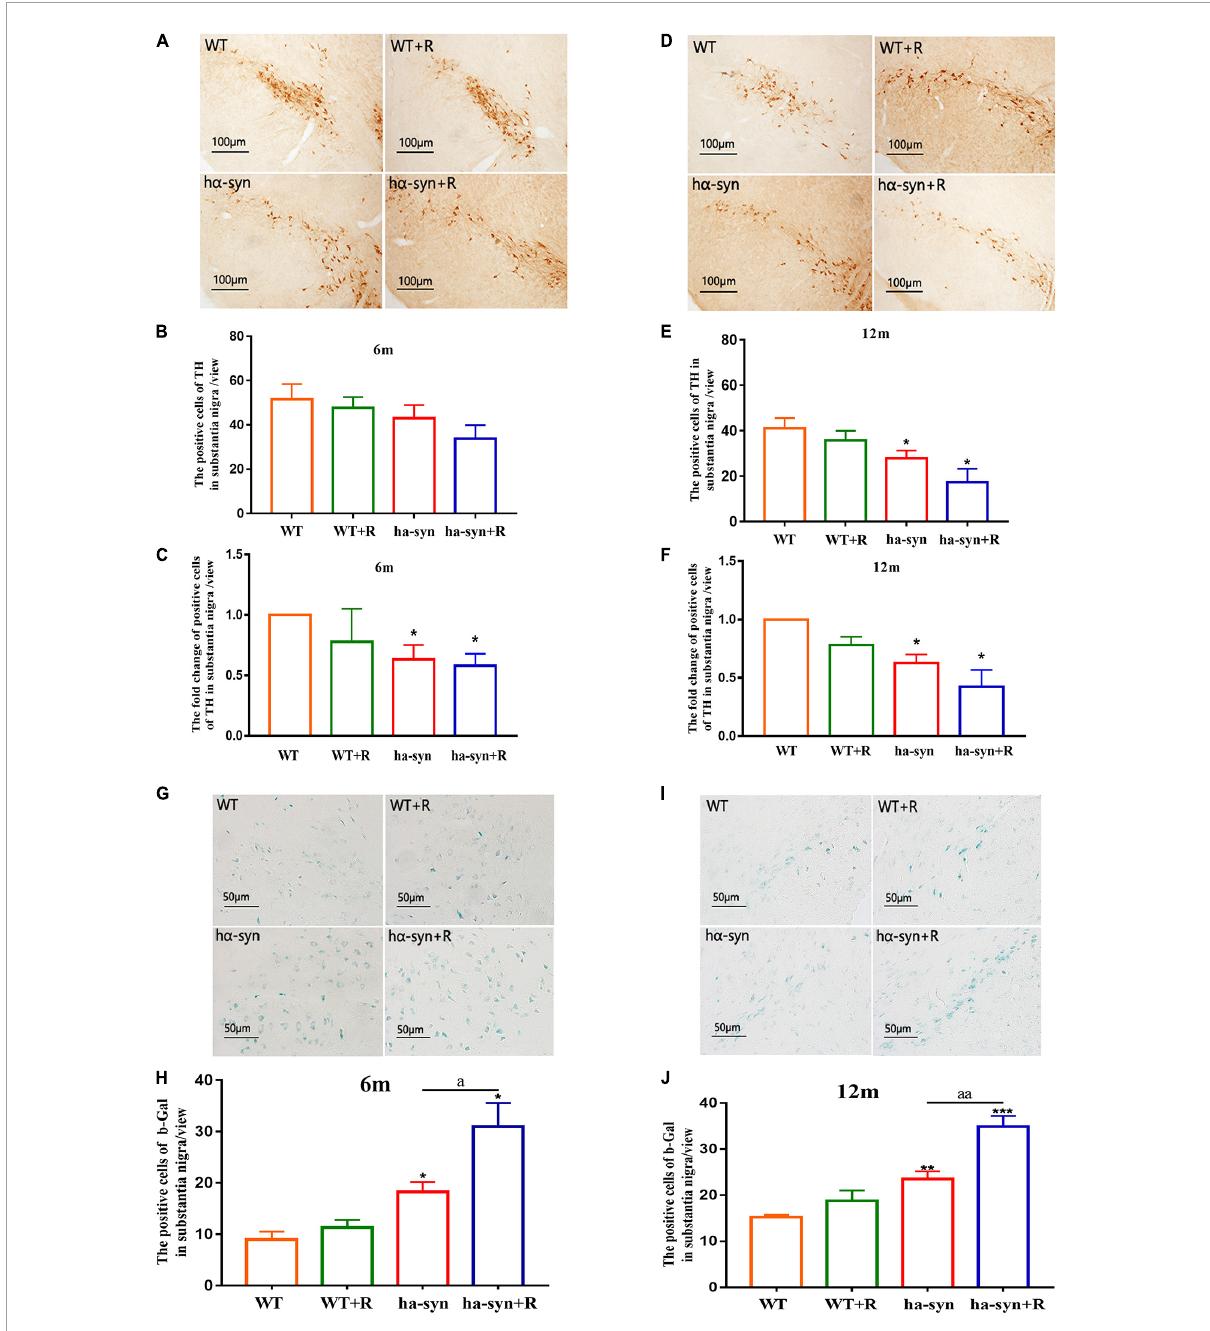
FIGURE2 Rotenone significantly decreased the number of TH-positive neurons and promoted cell senescence in the SNc of h α -syn + / − mice. The immunohistochemical technique combined with cell counting was used to detect the number of TH-positive neurons in the SNc of mice of different ages (A–F) . (A) Representative images showing TH-positive neurons in SNc of 6-month-old h α -syn + / − mice. (B) The number of TH-positive neurons in SNc of 6-month-old h α -syn + / − mice. (C) The fold change of TH-positive neurons in SNc of 6-month-old h α -syn + / − mice compared with the WT group. (D) Representative images showing TH-positive neurons in SNc of 12-month-old h α -syn + / − mice. (E) The number of TH-positive neurons in SNc of 12-month-old h α -syn + / − mice. (F) The fold change of TH-positive neurons in SNc of 12-month-old h α -syn + / − mice compared with the WT group. The senescent cells in the SNc of different ages were detected by β -gal staining combined with cell counting (G–J) . (G) Representative images showing β -gal staining in SNc of 6-month-old h α -syn + / − mice. (H) A number of positive cells of β -gal in SNc of 6-month-old h α -syn + / − mice. (I) Representative images showing β -gal staining in SNc of 12-month-old h α -syn + / − mice. (J) A number of positive cells of β -gal in SNc of 12-month-old h α -syn + / − mice. n = 6. * P < 0.05, ** P < 0.01, *** P < 0.001, compared with the age-matched WT group. a P < 0.05, aa P < 0.01, compared with the age-matched h α -syn + / −